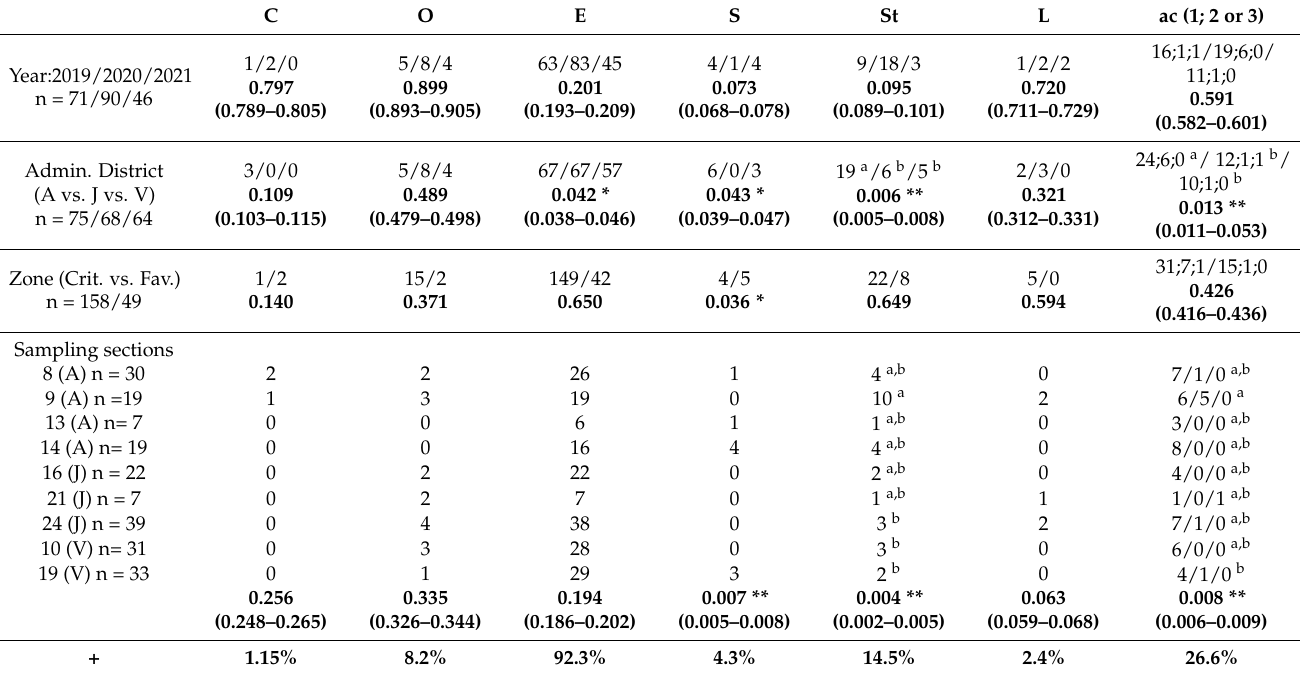
Table 3. Prevalence of all infections by year, administrative district, zone and sampling section. Positive assays: C = Cryptosporidium spp.; O = Omphalometra spp.; E = Eimeria spp.; S = Salmonella spp.; St = Staphylococcus spp.; L = Leptospira . (ac = accumulated number of positive assays from 0 to 3) with respect to each sample ( Eimeria spp. excluded). In bold: p -value (95% IC). * and ** for ≤ 0.05 and ≤ 0.01 significant level, respectively. Same superscripts (a or b) for proportions did not differ significantly each other Row “+”: Percentage of prevalence of pathogens in desman samples based on real-time PCR screening by